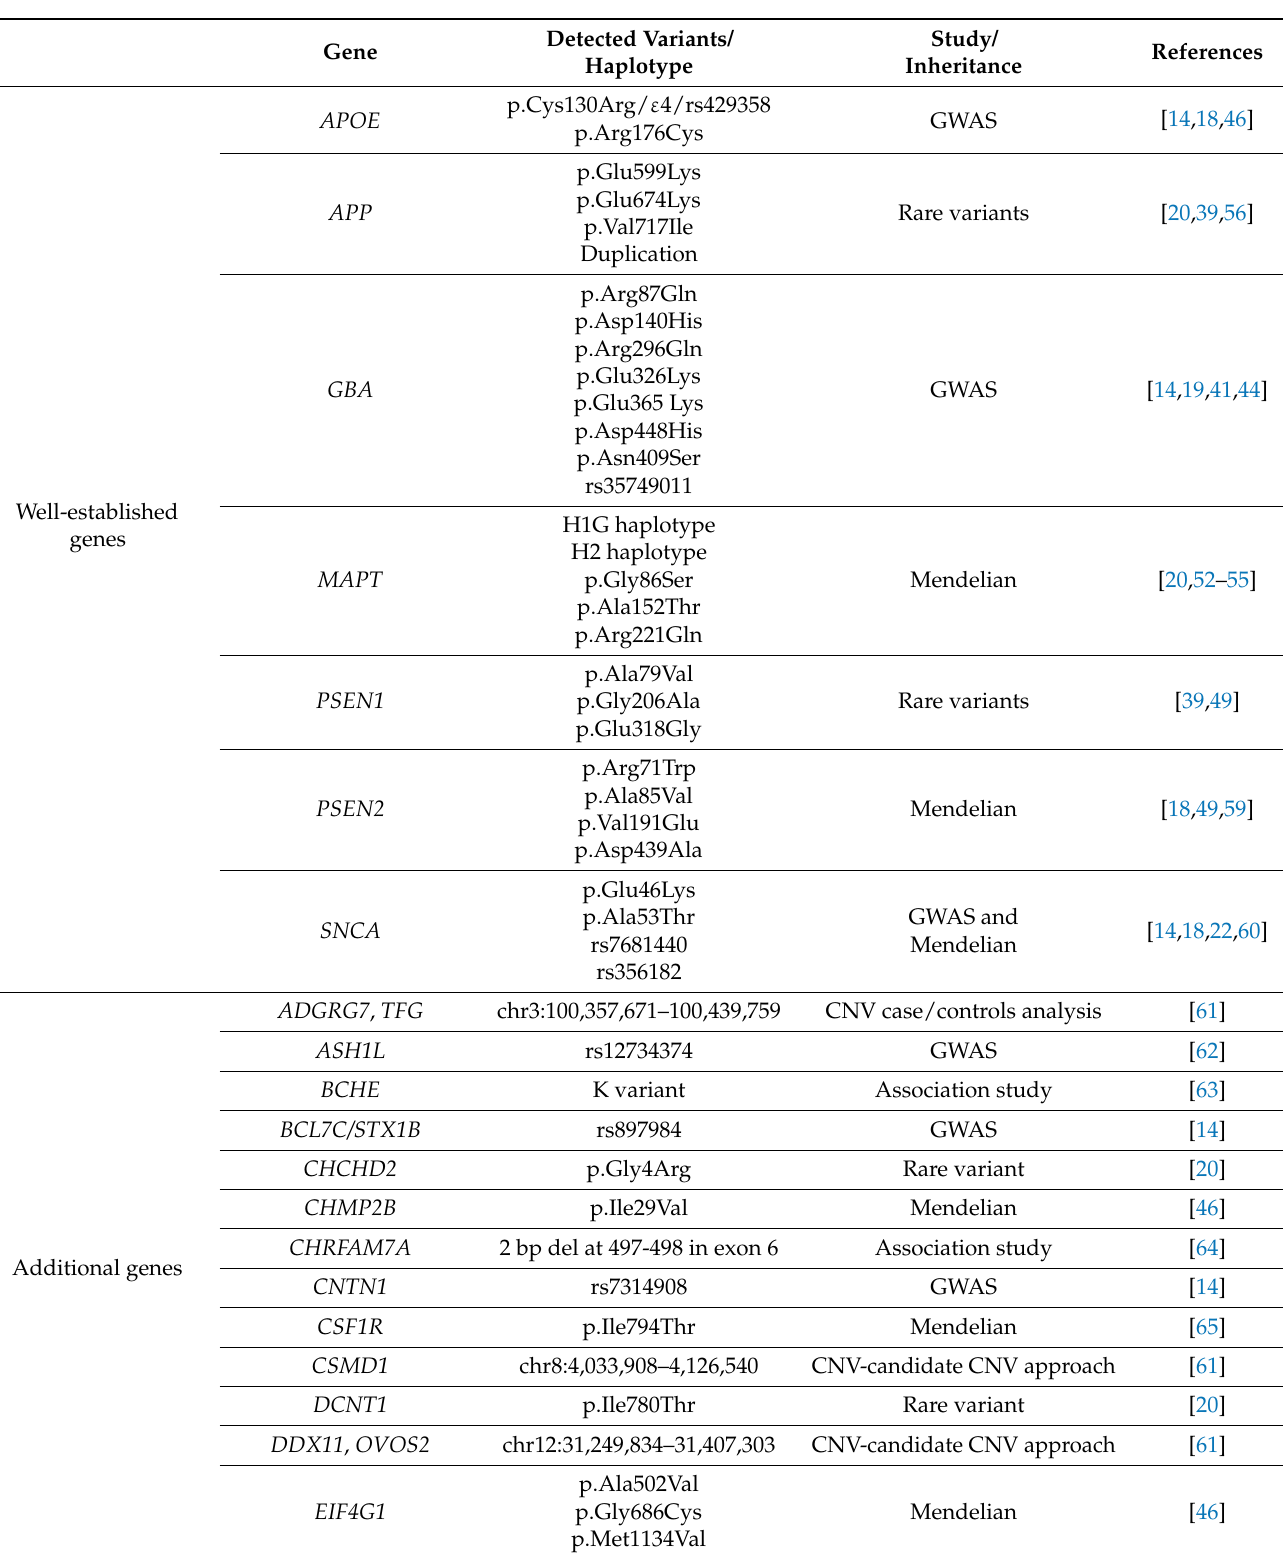
Table 1. Variants and haplotypes linked to DLB